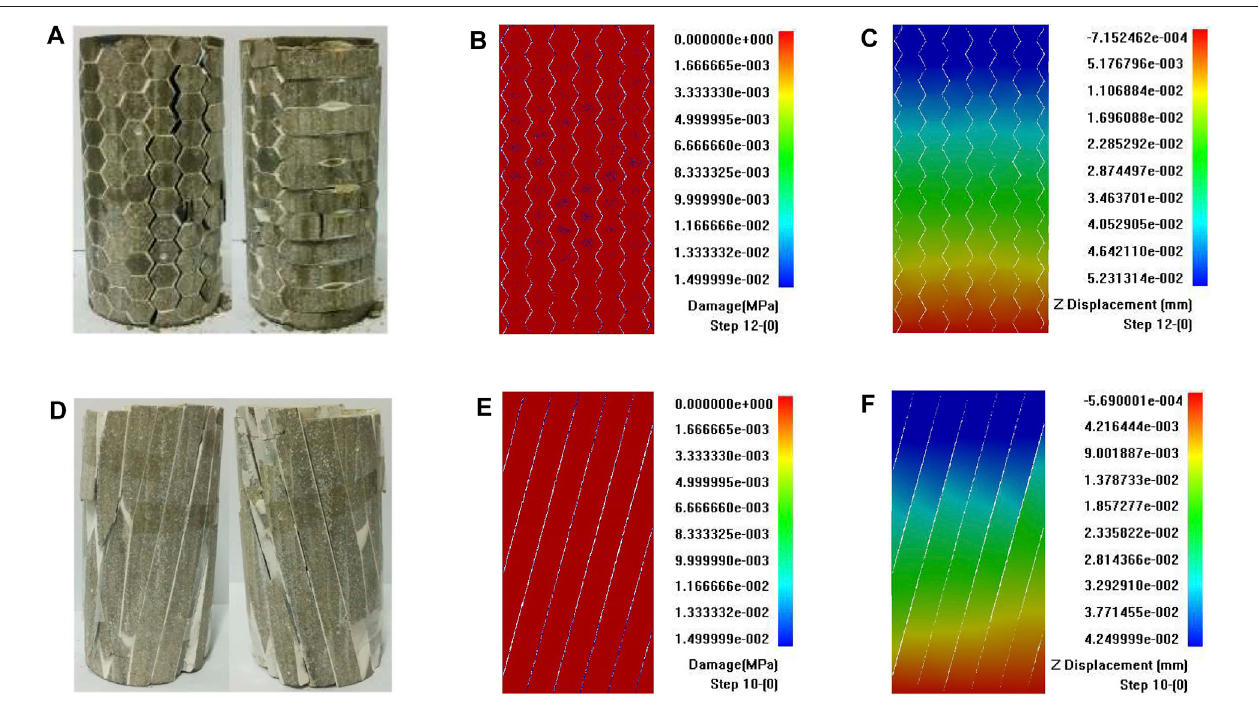
FIGURE3| Comparisonoftheobtainedfailurepatternsbysimulationandexperimentunderuniaxialcompression. (A) Physicaltestresultsofcolumnarjointedrock mass(CJRM) inthe direction orthogonal tothecolumn axis(Ji etal., 2017). (B) Damagediagram ofthenumericaltest ofCJRM (in thisstudy). (C) Displacementdiagram ofthenumericaltestofCJRM (inthisstudy). (D) PhysicaltestresultsofCJRMwith β (cid:2) 15 ° inthedirectionparalleltothecolumnaxis(Jietal.,2017). (E) Damagediagram of the numerical test of CJRM with β (cid:2) 15 ° (in this study). (F) Displacement diagram of the numerical test of CJRM with β (cid:2) 15 ° (in this study).